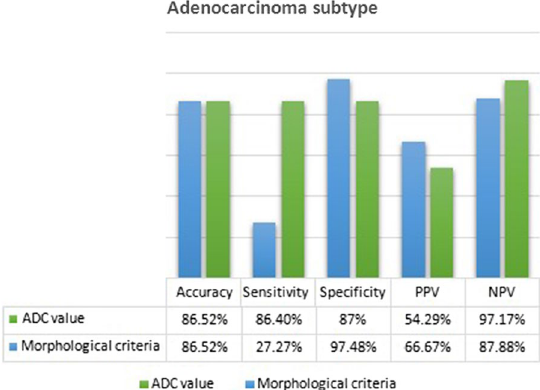
Fig. 5 Chart comparing ADC value versus morphological criteria for adenocarcinoma group